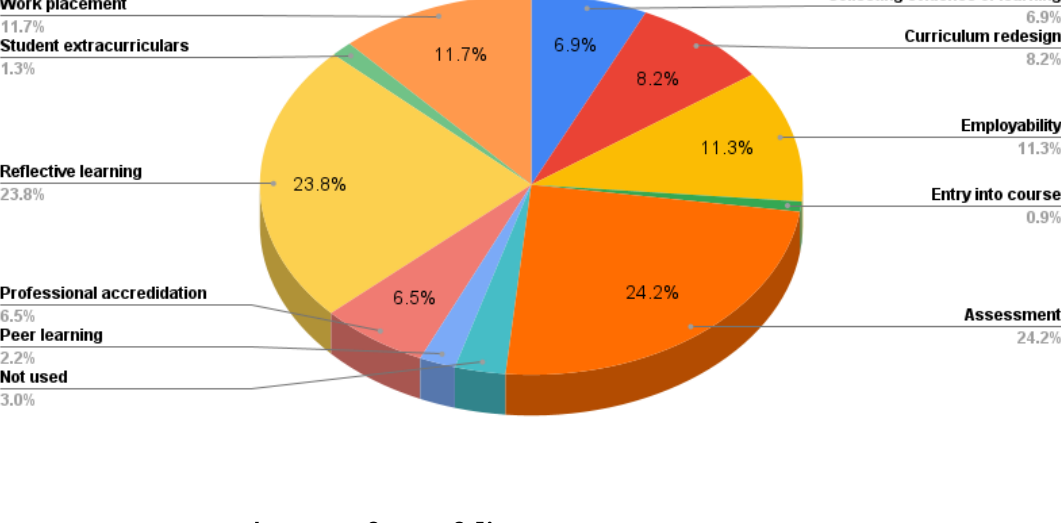
Figure 4. Purposes and usage of